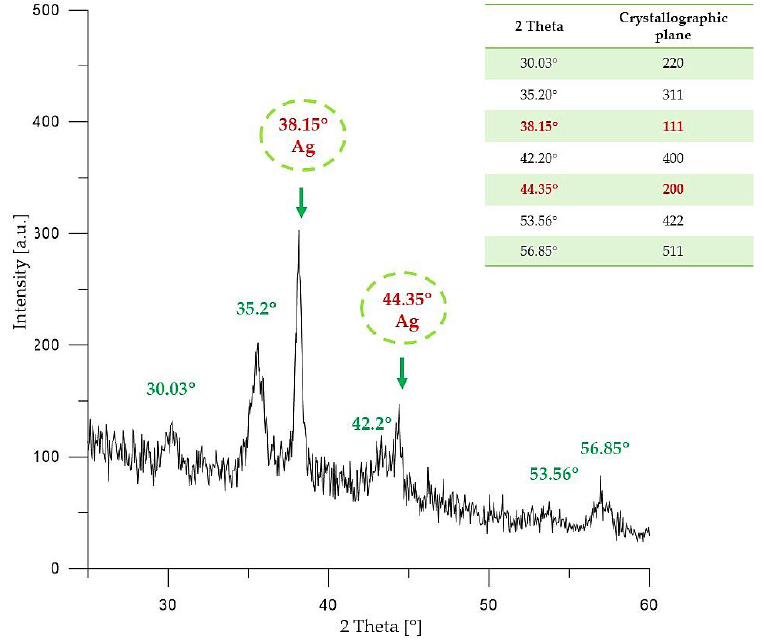
Figure 4. XRD pattern of Fe 3 O 4 @Ag particles.